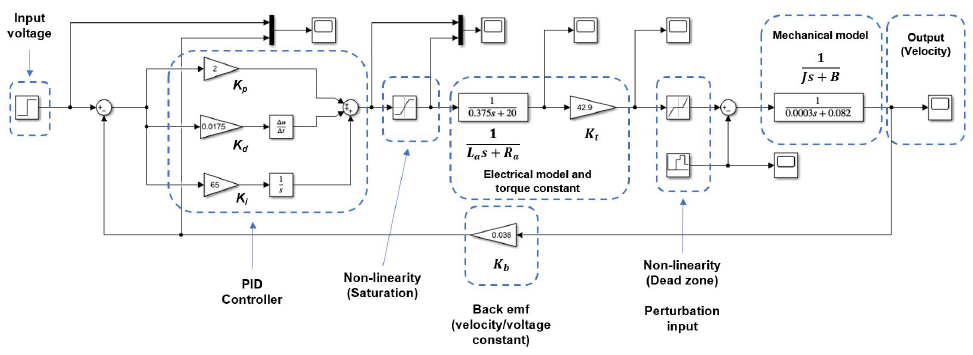
Figure 7. Block diagram representation for the closed-loop system including the PID controller.